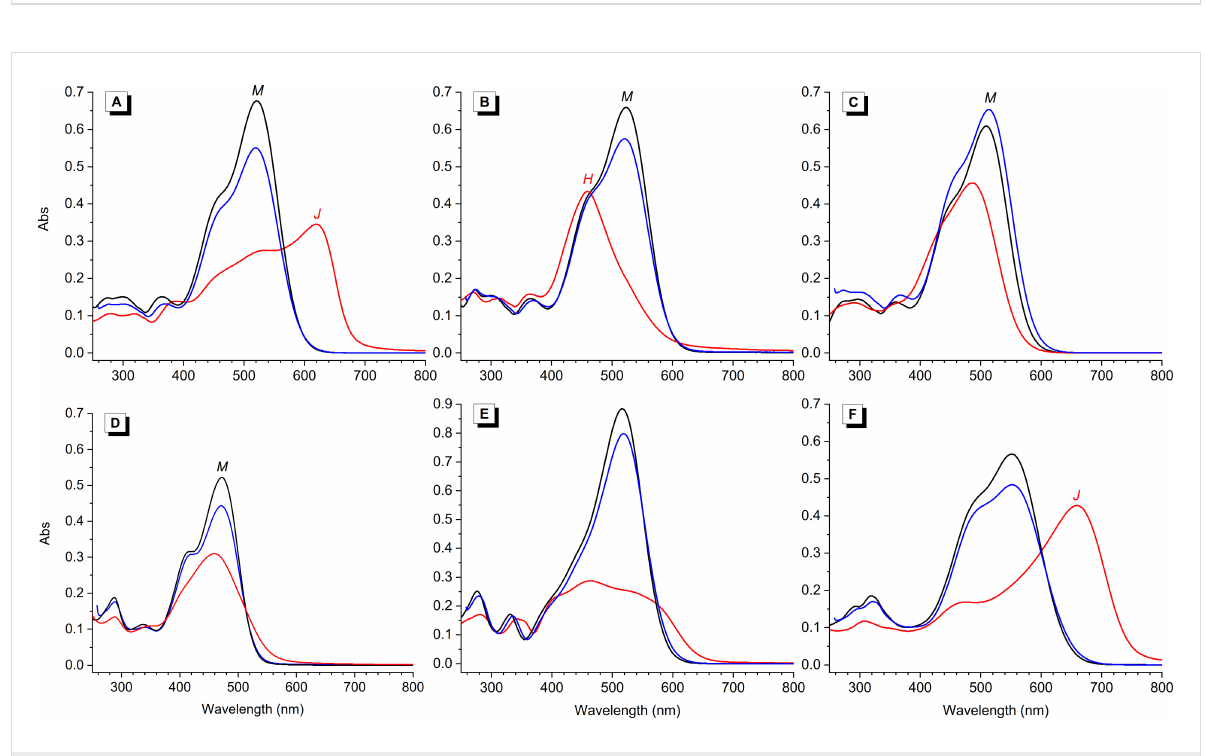
Figure 3: Representative absorption spectra of distyryl dyes: A) 1d , B) 1ð , C) 1f , D) 1u, E) 10a and F) 12a in DMSO (blue), MeOH (black) and K-100 aqueous buffer (red lines); c = 10 µM in all cases. Band assignment (when possible): M, monomer; H, H-aggregate; J, J-aggregate.